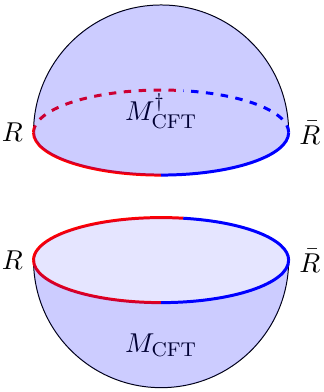
Figure 1 . The manifold M CFT (bottom) that we use in the Euclidean path integral to prepare our holographic state | ψ i and the CPT-conjugate manifold M † along their boundaries defines the manifold M double := M † then M † is equivalent to M CFT , the two manifolds are exchanged by the relevant notion of time- CFT reversal, and this symmetry leaves invariant the boundary ∂M CFT = ∂M † The surface ∂M CFT is partitioned into regions R (red) and ¯ R